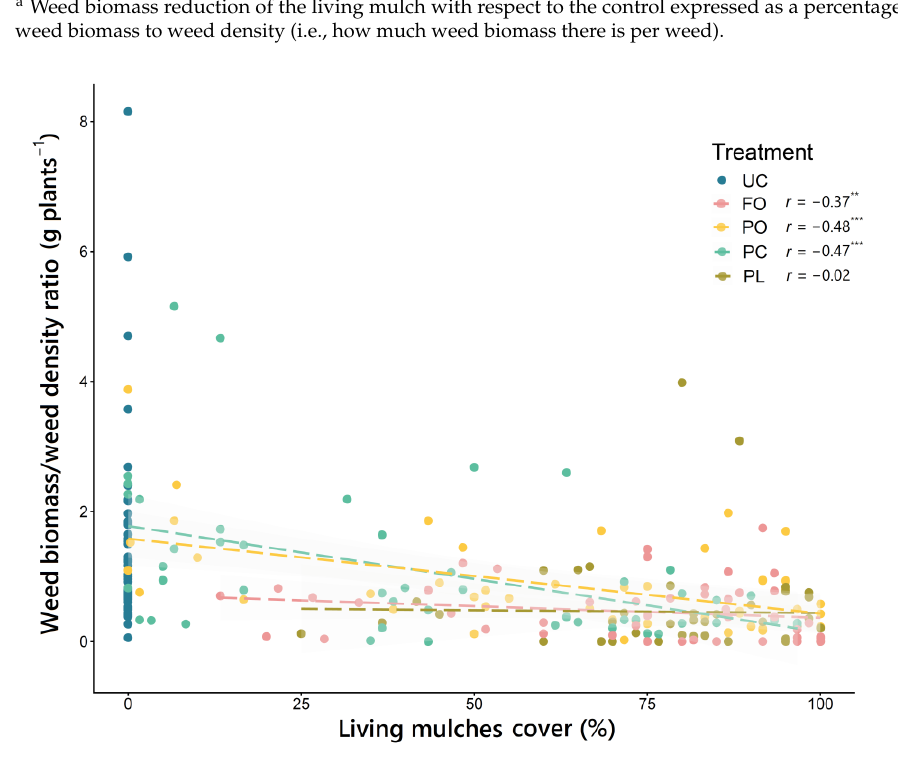
The different treatments applied explained part of the variance observed in grapevine vegetative growth (based on pruning weights), both on farm A ( R 2 m = 0.36) and farm B ( R 2 m = 0.24) (Figure 6). However, although a slight reduction in pruning weights was observed in living mulches compared to weed-free control (WC) on both farms, there were no significant differences between treatments. An analysis of the relationship between grapevine vegetative growth and weed biomass showed a negative correlation between the two variables, with pruning weight being lower the higher the weed biomass (Figure 7). However, this correlation was only significant on farm A ( r = − 0.51*), while on farm B, it was clearly weaker ( r = −